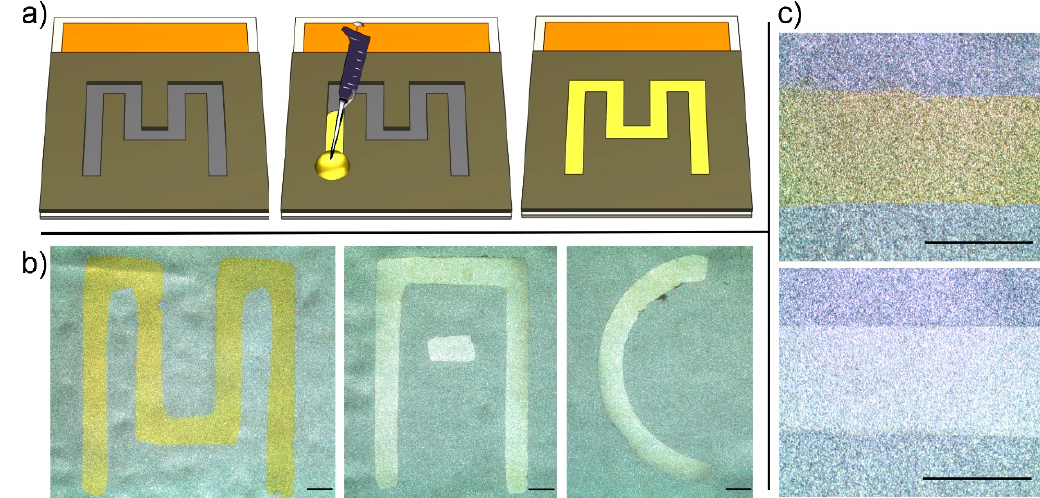
Figure 5. Parallel electrodeposition of gold and silver in the shape of English alphabet letters on a nickel-coated substrate. ( a ) A schematic view of the process for printing gels by using microfluidic flow (from left to right); ( b ) a microscope image of a deposited layer of gold in the shape of an “M” and a deposited layer of silver in the shape of “A” and “C”; ( c ) a microscope image of a deposited layer of gold and silver showing well-defined edges (scale bar = 1 mm).